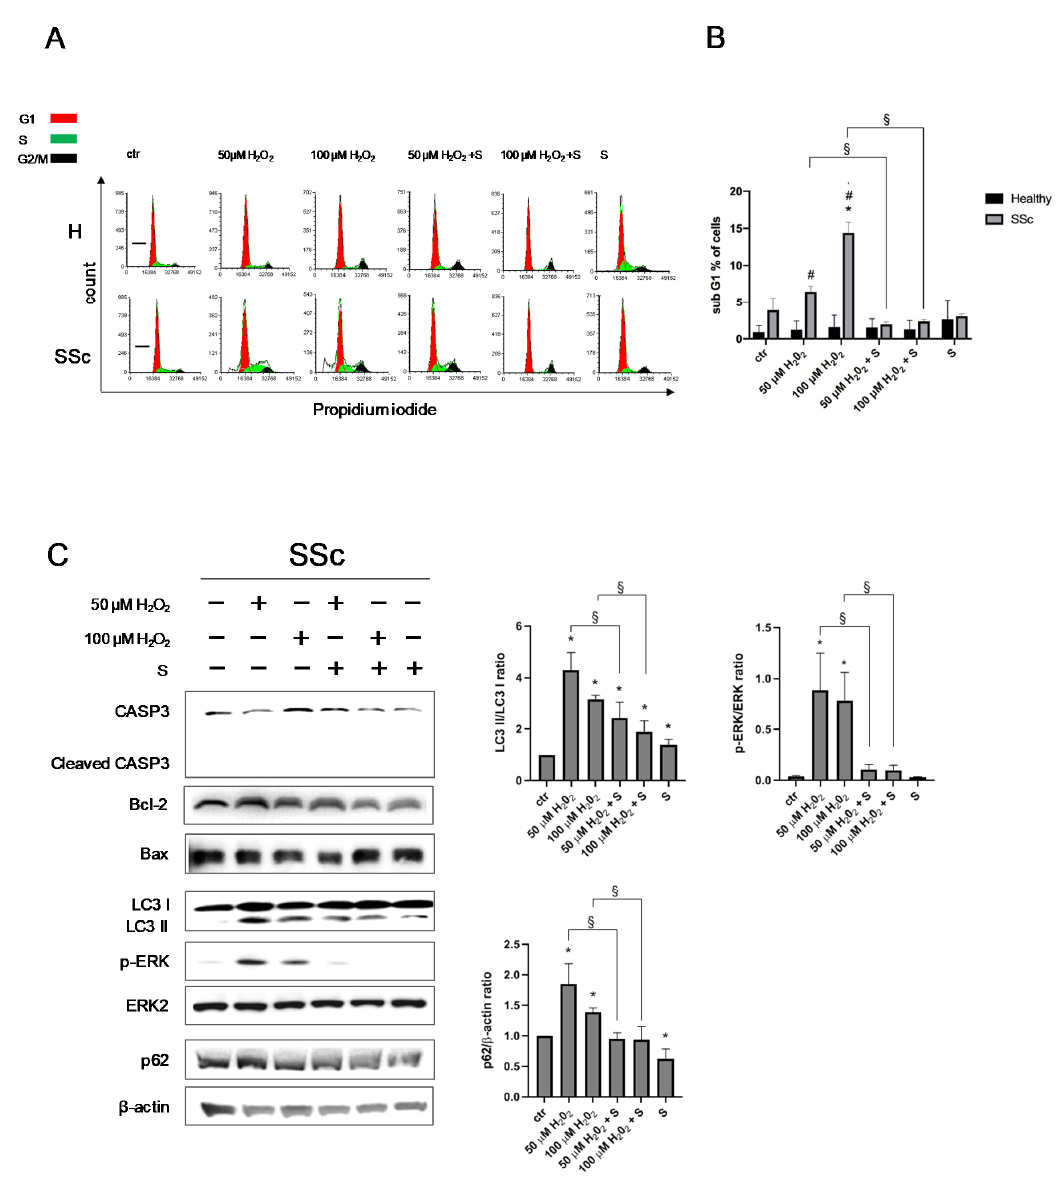
Figure 3. Analysis of the cell viability in healthy control (H) and SSc fibroblasts exposed to a pro-oxidant environment. ( A ) The cell cycle progression of H and SSc fibroblasts stimulated with 50 and 100 µ M H 2 O 2 for 24 h in the presence or in absence of sildenafil 1 µ M. ( B ) Histogram represented the percentage of cells in the G1 subphase in healthy (black columns) and in SSc (grey columns) fibroblasts. ( C ) At the same experimental conditions, CASP3, cleaved CASP3, Bcl-2, Bax, and LC3 I and II, as well as ERK2, p-ERK, and P62, were analyzed in SSc fibroblasts though immunoblotting. Histograms depicted the densitometric analysis (mean ± SE) expressed as ratios of LC3 II / LC3 I, p-ERK / total ERK2, and P62 / β -actin. * p < 0.05 vs. ctr, # p < 0.05 healthy vs. SSc, and § p < 0.05 H 2 O 2 vs. H 2 O 2 + S. S, sildenafil, and CASP3,